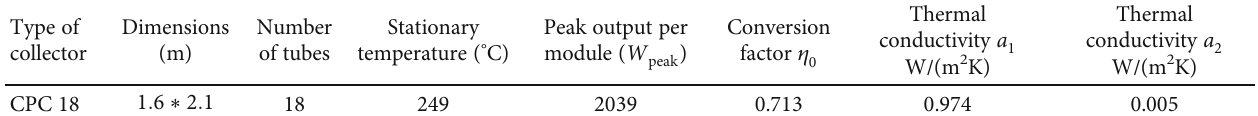
Table 3: The technical details of the used solar thermal collector (CPC 18) [33].